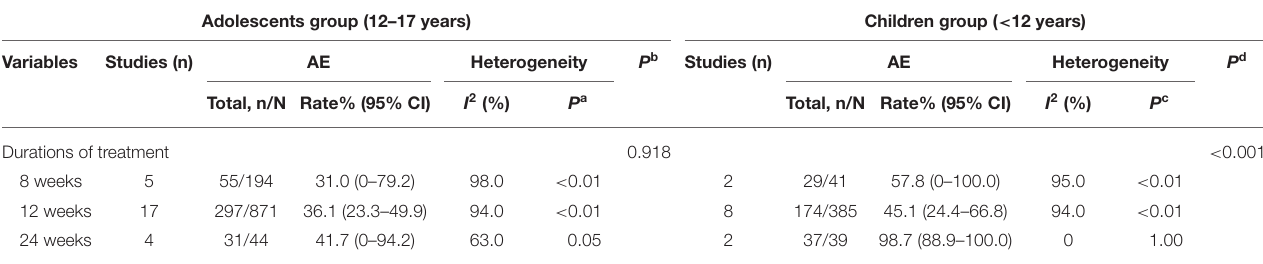
TABLE 3 | AEs after different treatment durations in children and adolescents.